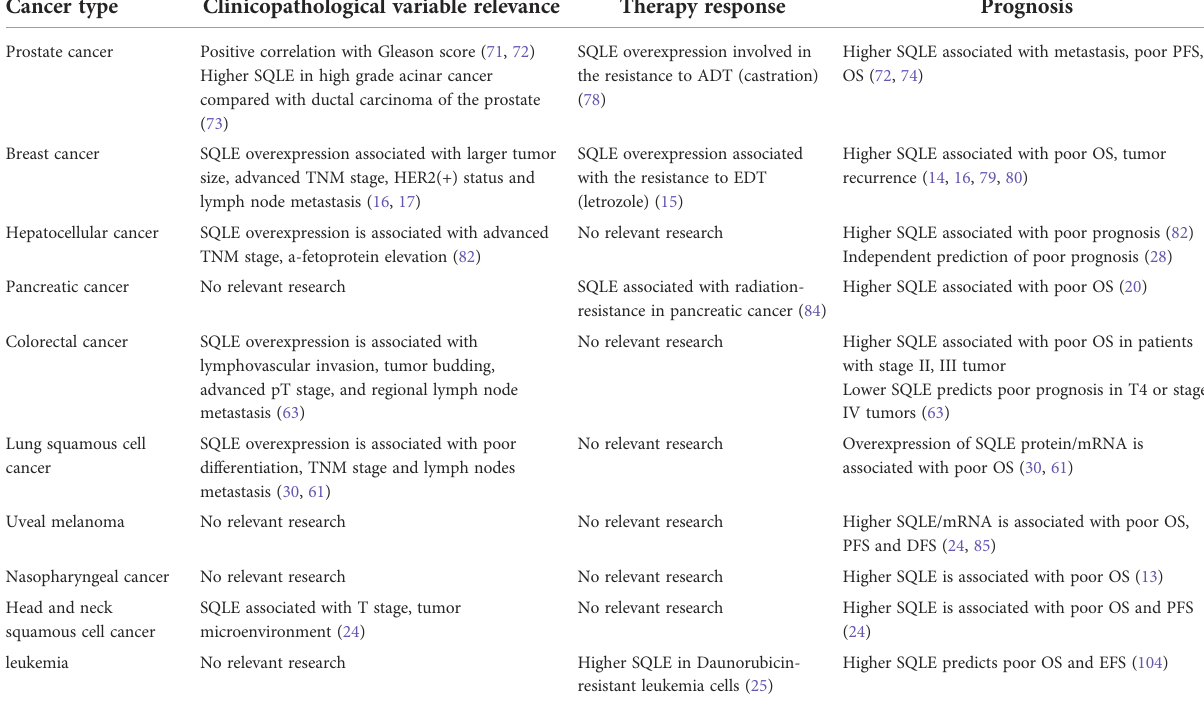
TABLE 1 Clinical relevance of SQLE in